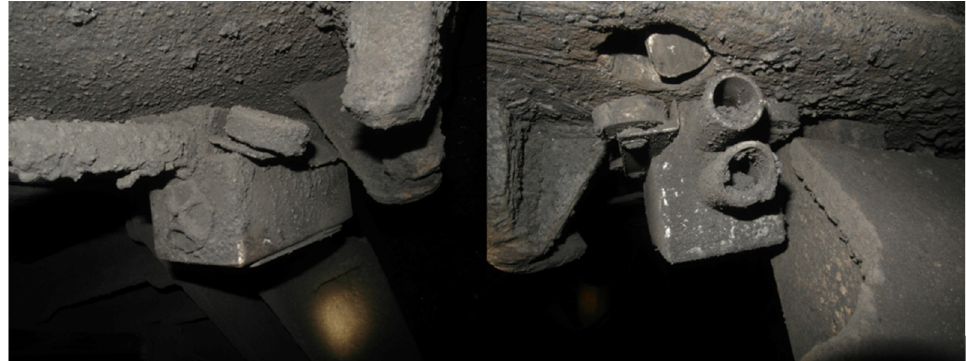
Figure 7. SSMS-S sensor in operation: harsh conditions.